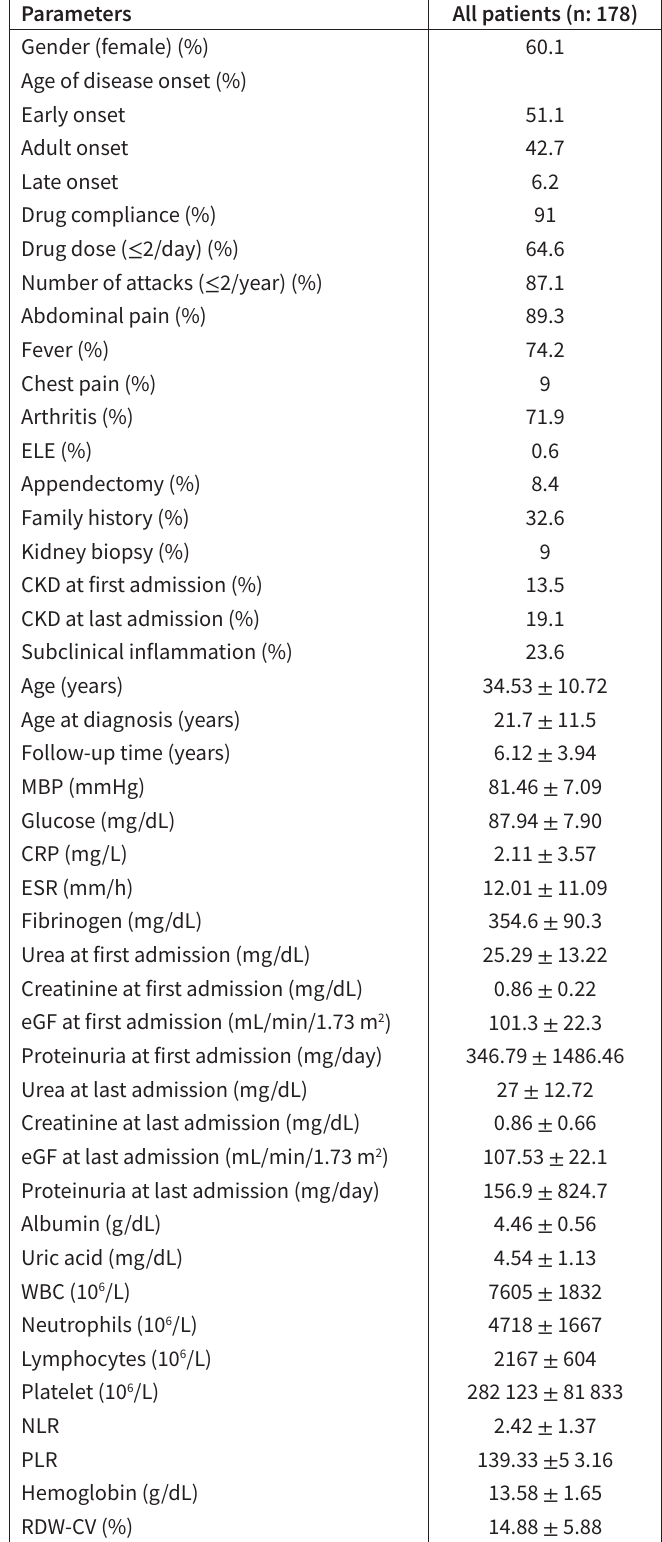
Table 1. Clinical Features and Laboratory Data of All Patients